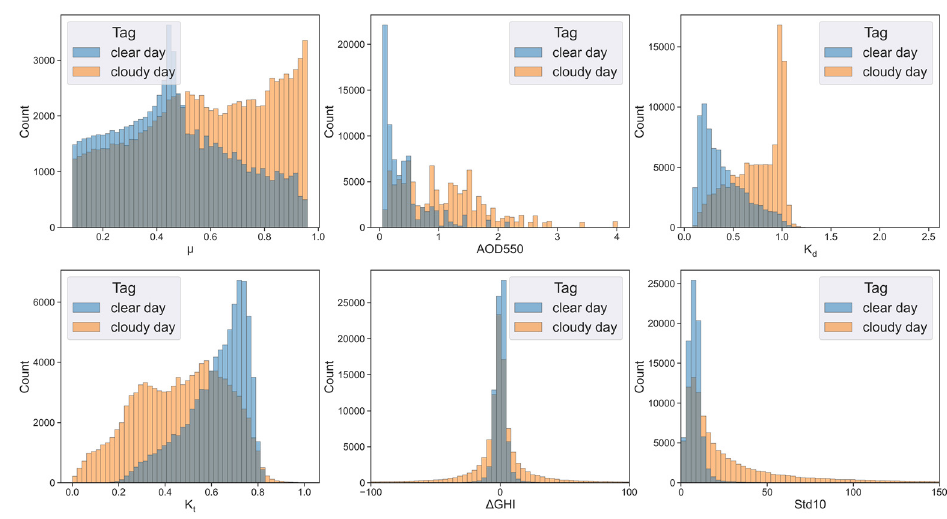
Figure 3. The histogram of samples (year of 2005) against different sky conditions (blue for clear and orange for cloudy).